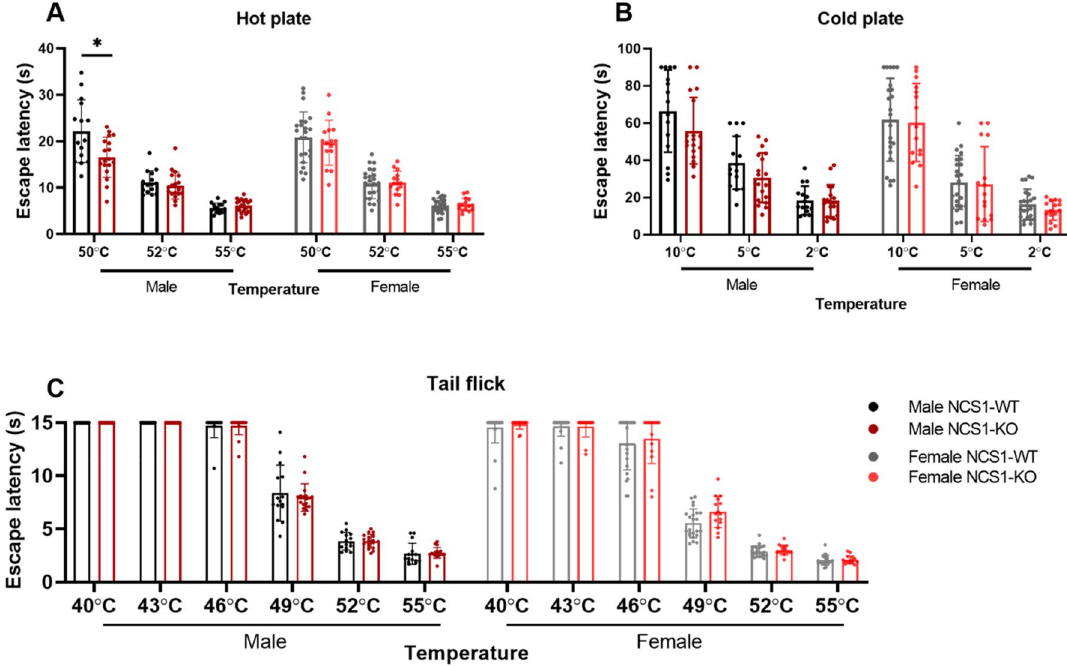
Figure 1. NCS1-WT and -KO mice exhibit mostly similar thermal sensation. ( A ) Compared to male NCS1-WT mice, male NCS1-KO mice displayed a shorter escape latency in a hot plate test only at 50 °C (2-way ANOVA, Factor genotype, p = 0.03, followed by multiple comparison test with Sidak’s correction, temperature 50° C, p = 0.03). No differences were observed between female NCS1-WT and NCS1-KO mice (2-way ANOVA, Factor genotype, p = 0.75). No differences were found at any temperature between NCS1-WT and NCS1-KO mice in the ( B ) cold plate test [2-way ANOVA (male), Factor genotype, p = 0.13; 2-way ANOVA (female), Factor genotype, p = 0.66] and ( C ) tail flick test [2-way ANOVA (male), Factor genotype, p = 0.81; 2-way ANOVA (female), Factor genotype, p = 0.21]. Error bars show SD. Male NCS1-WT: n = 15, male NCS1-KO: n = 18, female NCS1-WT: n = 15, female NCS1-KO: n =